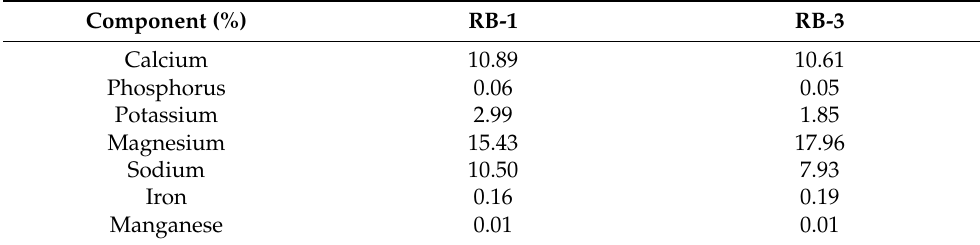
Table 1. Chemical composition of buffer